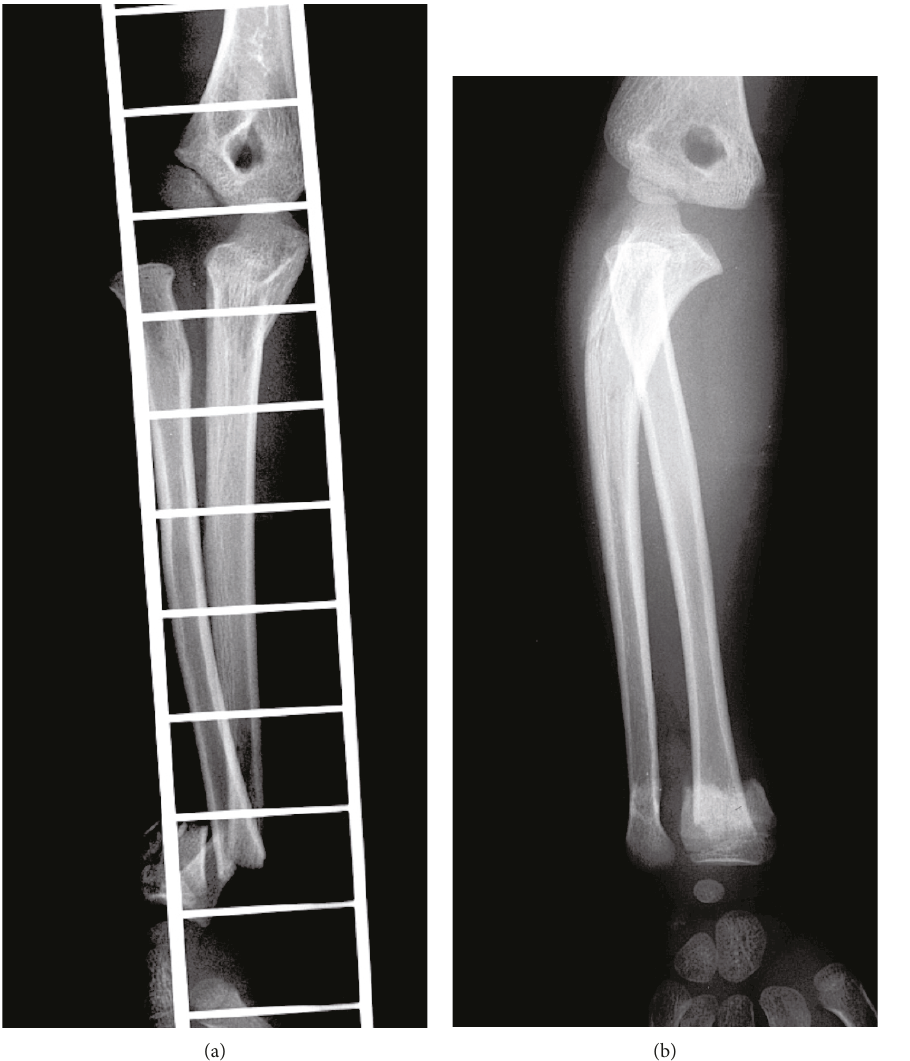
Figure 1: X-rays at fi rst visit. A Bado type III Monteggia fracture and fractures of the distal radius and ulna were observed on the same side. (a) AP view of the elbow joint. (b) Oblique view of the elbow